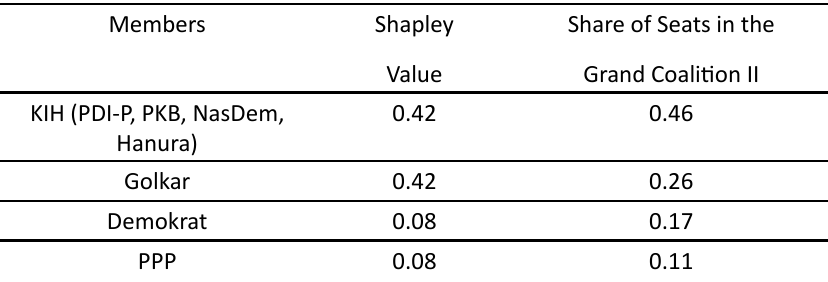
Table 4: Shapley Value and Seats in Parliament of the